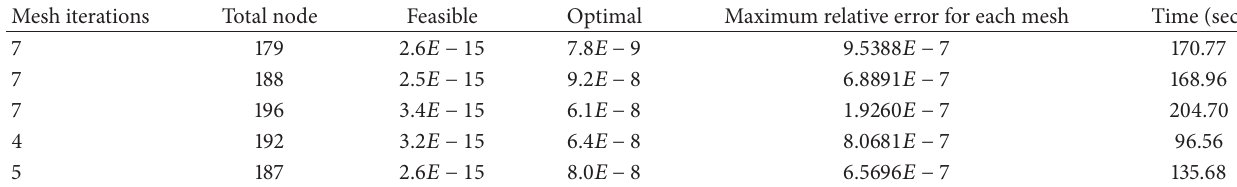
Table 4: Optimal results by